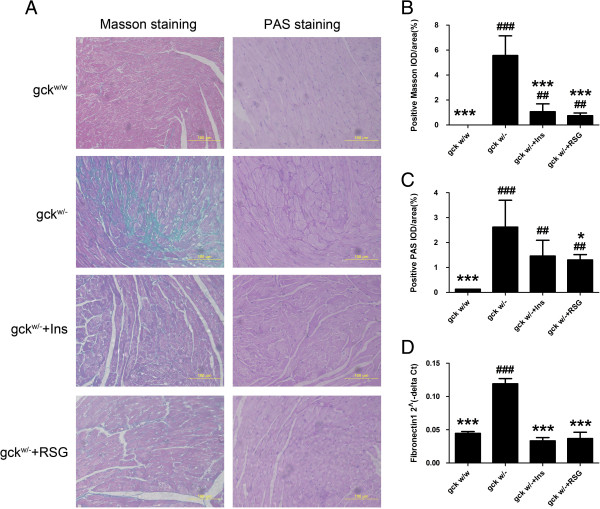
Cardiac fibrotic levels in 60-week old liver-specific gck knockout mice. Cardiac fibrosis levels were investigated in wild-type (gckw/w) and gck knockout (gckw/–) mice as well as knockout mice treated with insulin or rosiglitazone for 4 weeks. Images of PAS and Masson staining are shown in (A) with positive Masson IOD/area (B), and positive PAS IOD/area (C) shown. The relative amount of mRNA for fibronectin 1 in the myocardial, which was determined by real-time PCR and corrected with beta actin as an internal standard, is shown in (D). n = 3 for all samples. Asterisk (*) refers to statistical significance (P < 0.05 for * and P < 0.001For ***) in comparisons with gckw/– mice, while # refers to statistical significance (P < 0.005 for ## and P < 0.001 for ###) in comparisons with gckw/w mice.